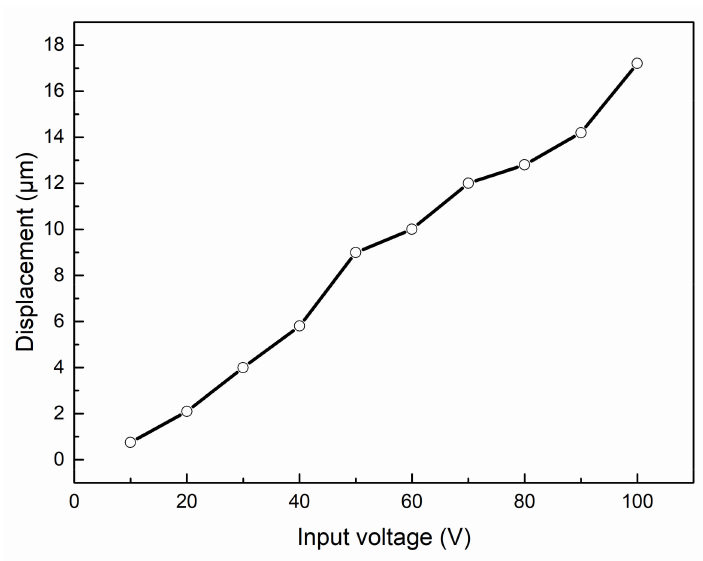
Figure 18. Displacement of the piezoelectric ceramic versus input voltage.